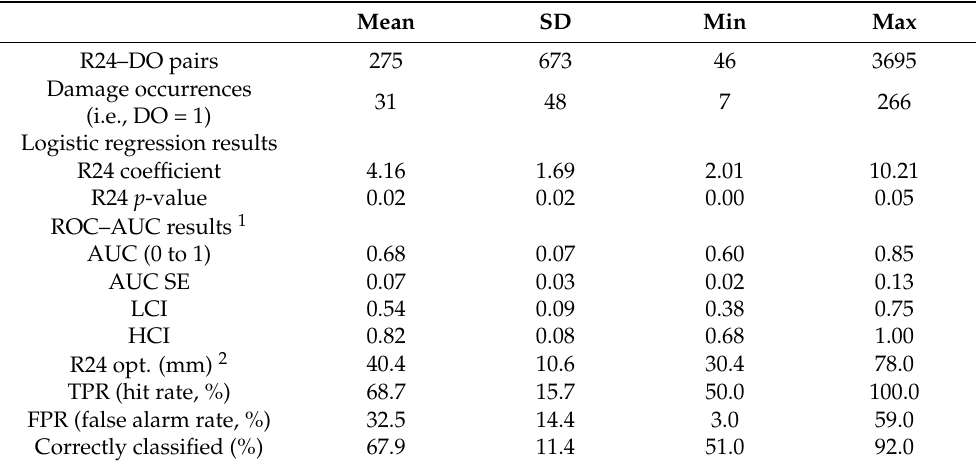
Table 4. Statistics (mean, standard deviation (SD), min, max) of R24–DO pairs, logistic regression results, and ROC–AUC results for the municipalities and the merged ones with significant model performance (N = 28).